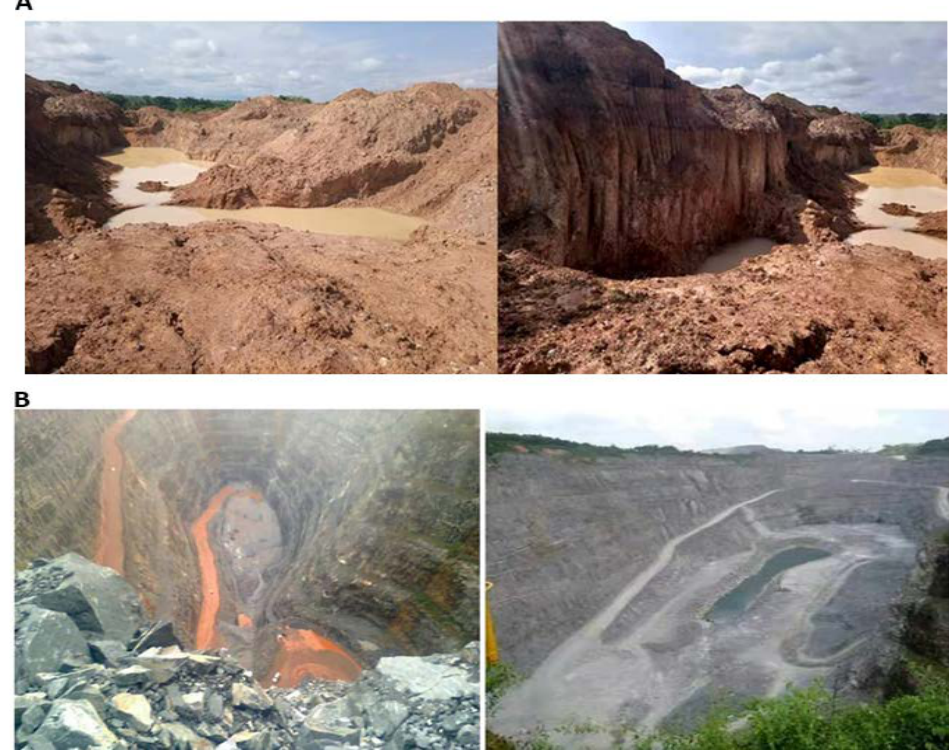
Figure 11. ( A ) Degraded land due to mining activities (excavation), ( B ) blasting and pitting (Adamus pit) caused massive land degradation, August (2020).